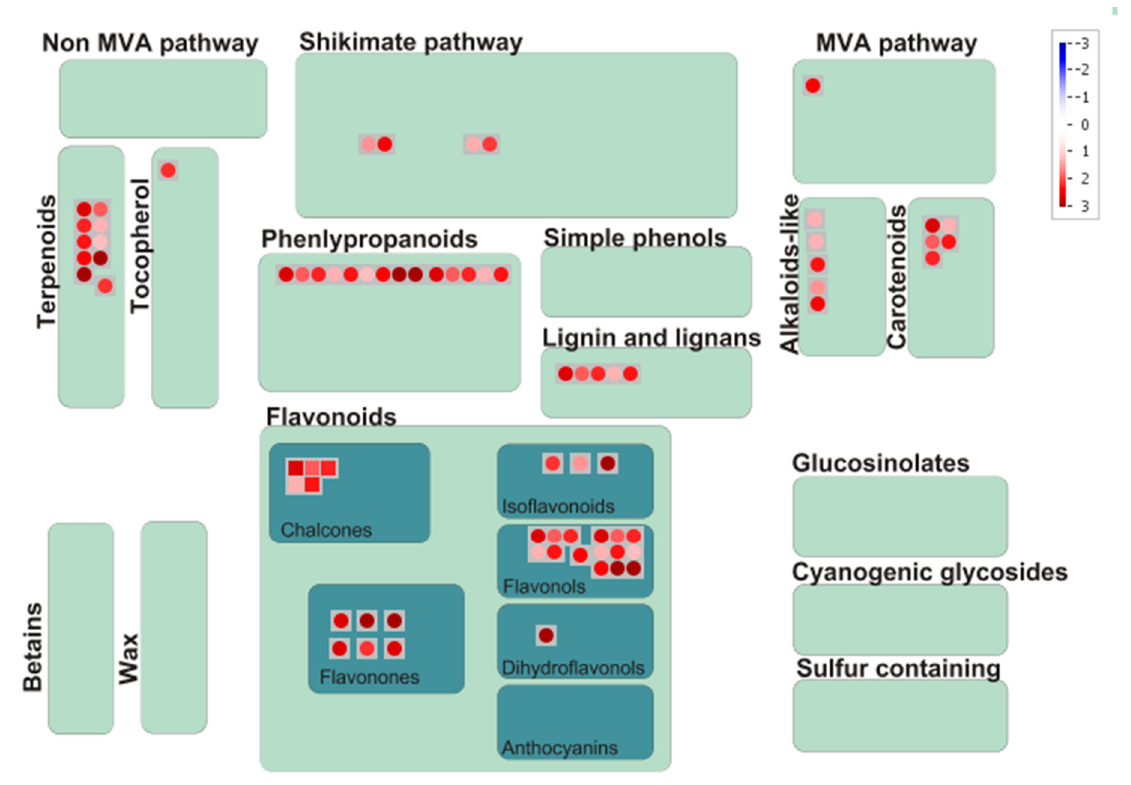
Figure 10. Pathway mapping of secondary metabolites up-regulated in the colored sorghum grains over the white grains.